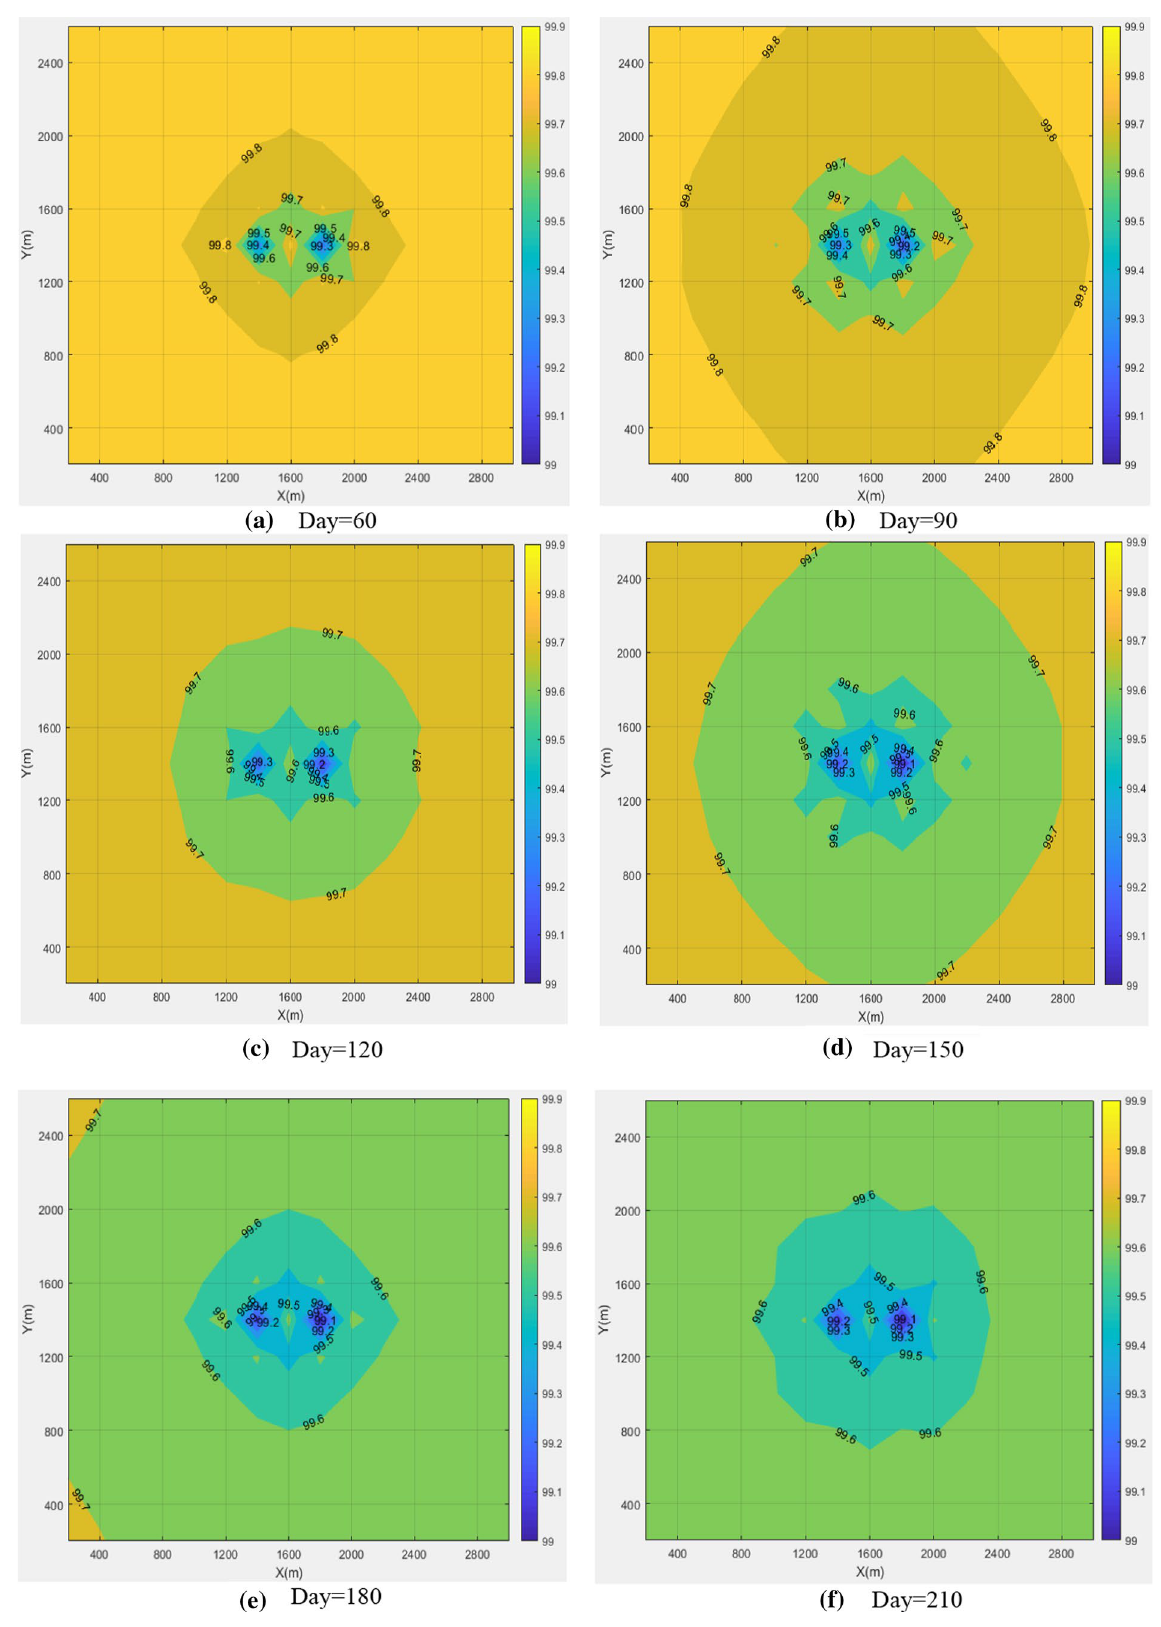
Fig. 5 Fluctuations of simulated water table using IGA model on internal control